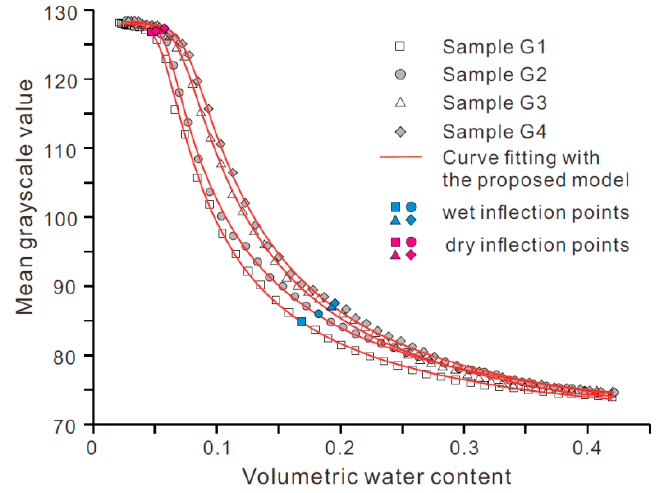
Figure 8. WGCCs for samples with different particle size distributions.